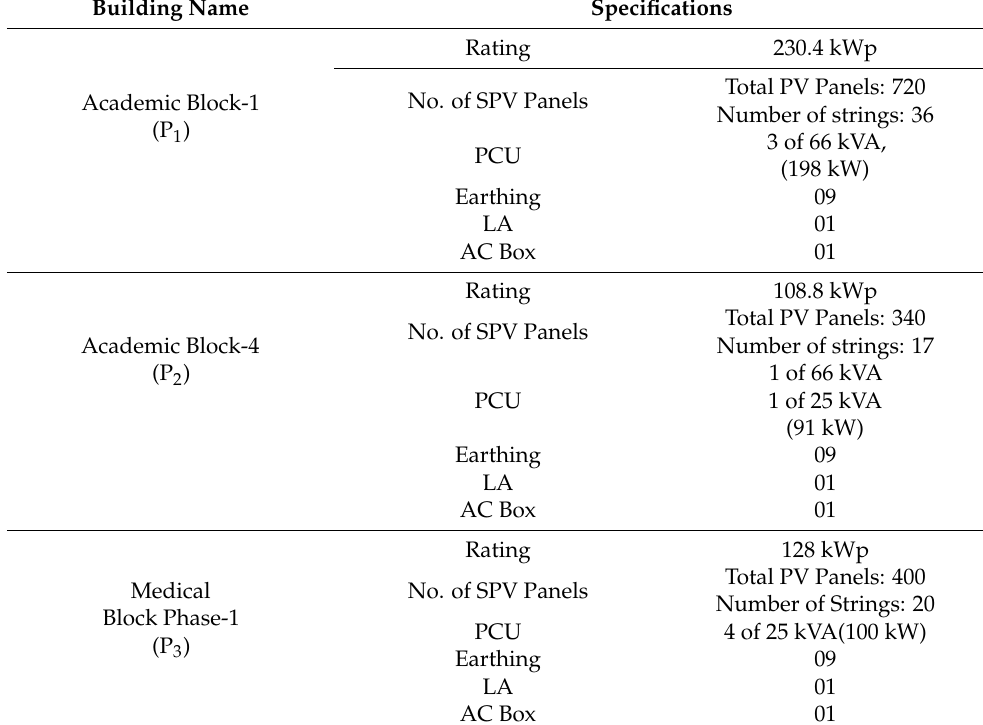
Table 2. Installed Solar Plant